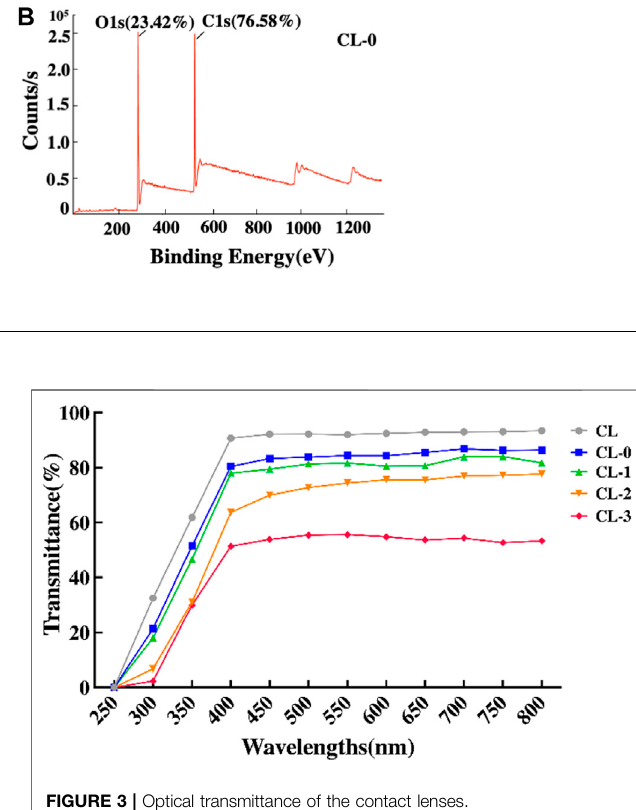
FIGURE 3 | Optical transmittance of the contact